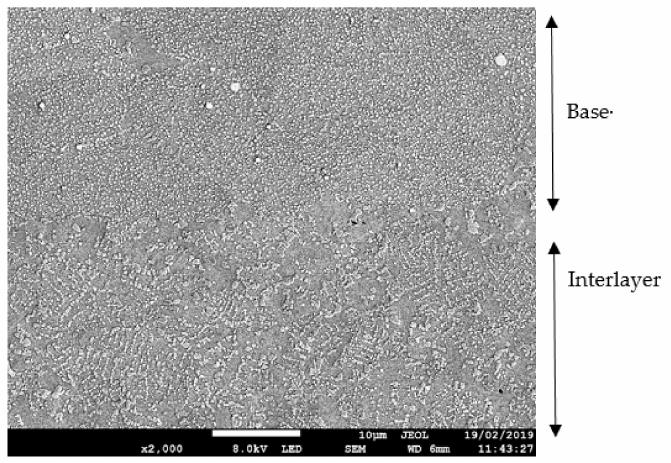
Figure 7. FEG SEM image of interlayer in bond